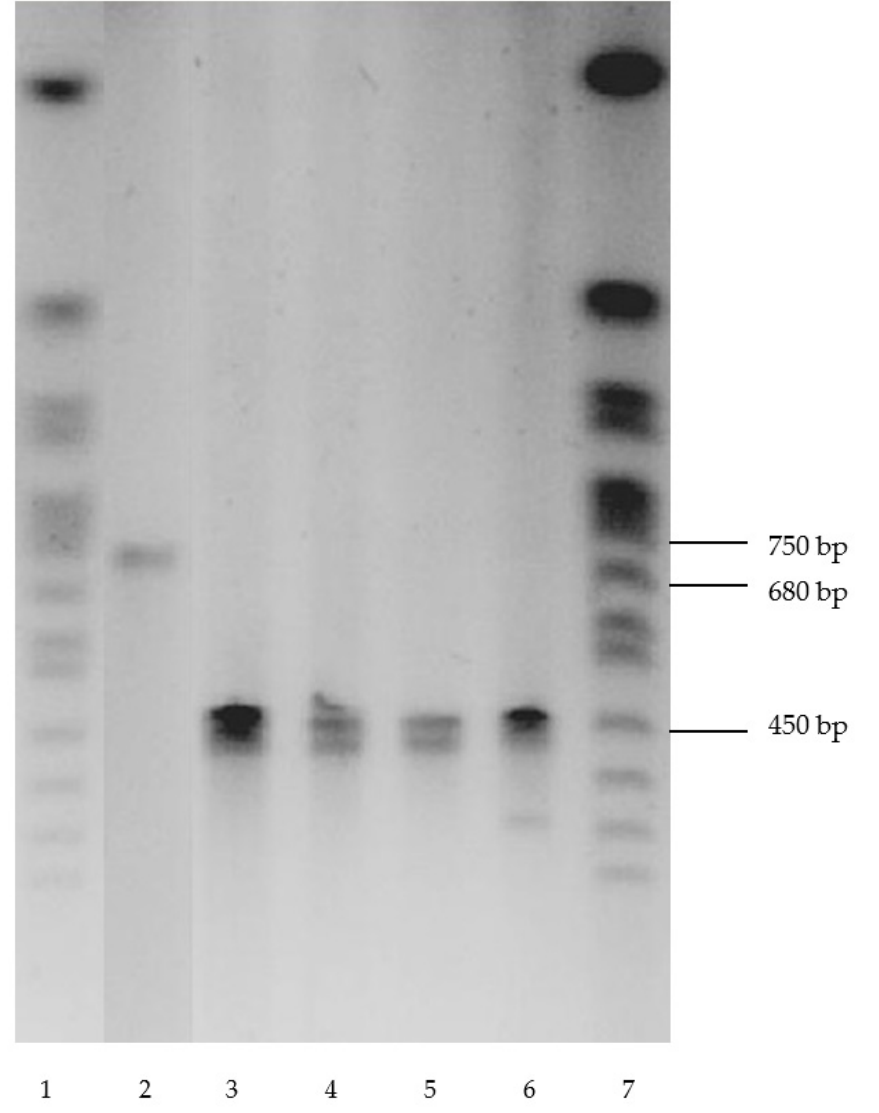
Figure 2. Electropherogram of plasmid DNA: 1, 7—DNA Size Markers—Yeast Chromosomal molecular weight marker (Bio-Rad Laboratories, Hercules, CA, USA), 2—1CP, 3—G10, 4—P1-1, 5—